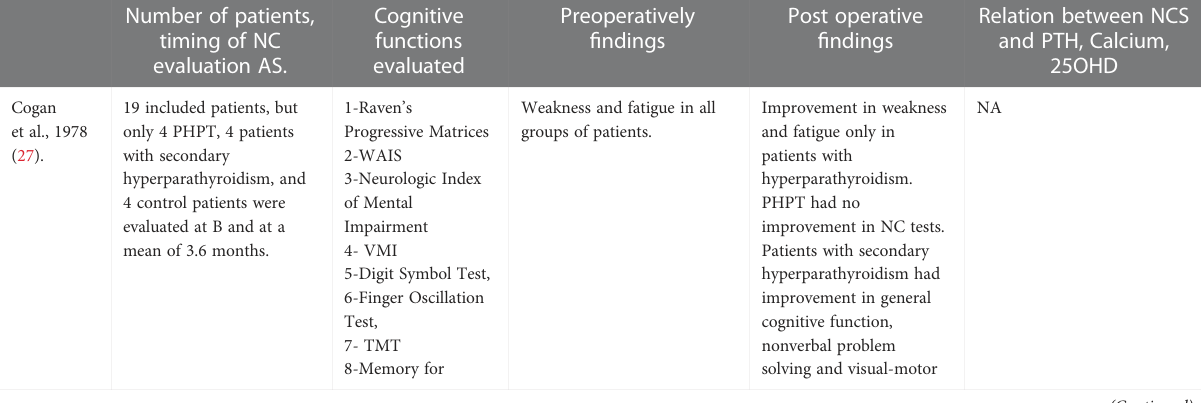
TABLE 4 Review of studies with neurocognitive evaluation of primary hyperparathyroidism patients at baseline and after parathyroidectomy. Number of patients, timing of